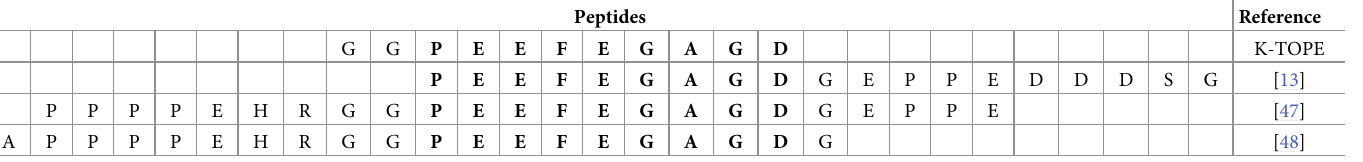
Table 3. Alignment of an HSV2-specific glycoprotein G2 epitope with previously reported epitopes.